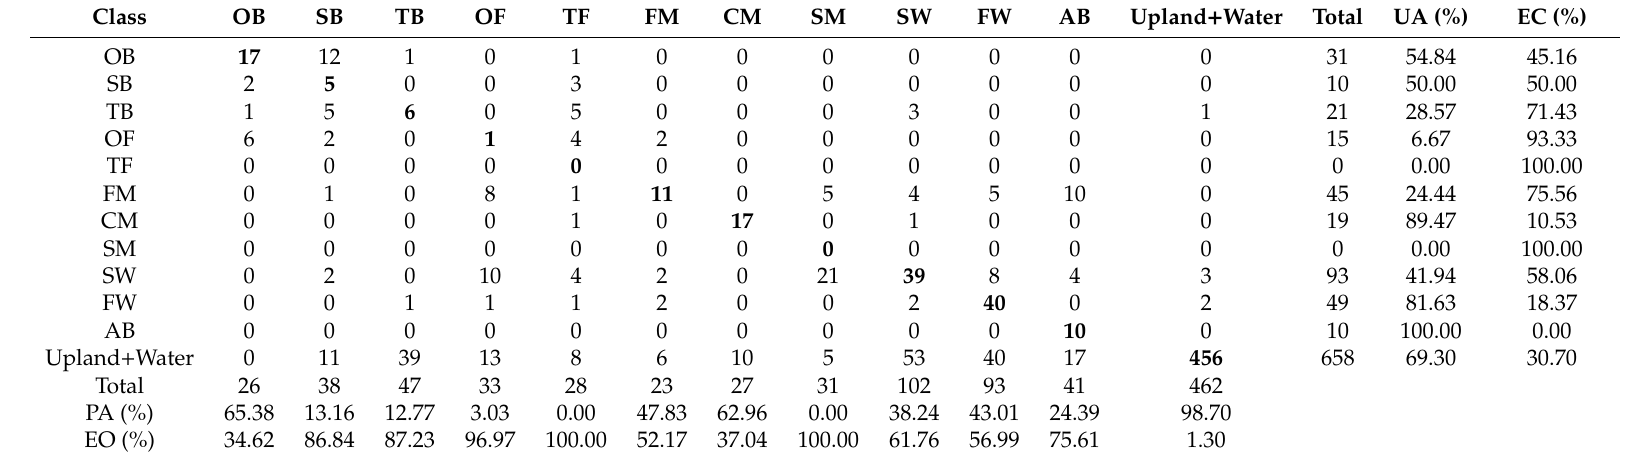
Table 11. Confusion matrix (in the number of sites) and associated accuracies when comparing the 2016 NB reference map to 951 in-situ GPS field